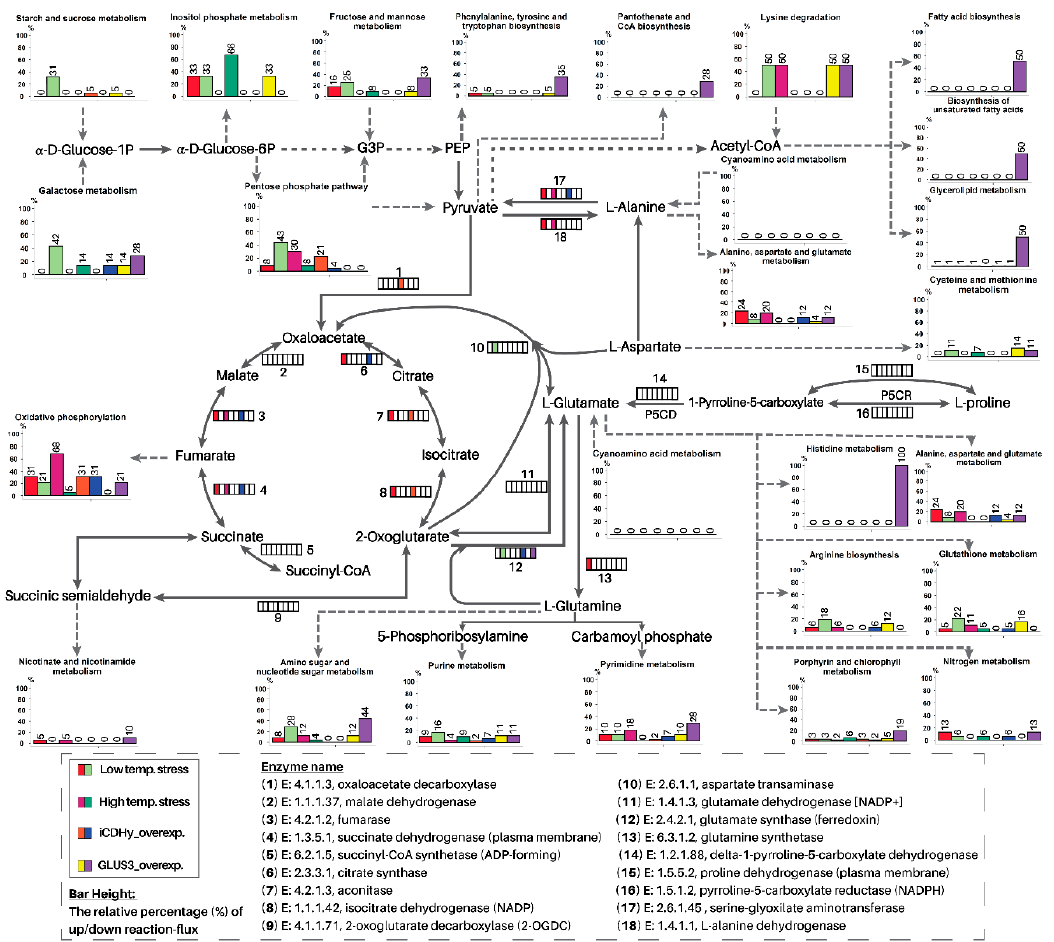
Figure 3. Schematic diagram representing the analysis of simulated metabolic flux of (i) the cells were grown at a low temperature (22 °C) and high temperature (40 °C), in comparison to that of the control, and (ii) the in silico overexpression of isocitrate dehydrogenase (iCDHy) and GlsF, in comparison to that of the control. The control is the simulated flux of the wild-type strain under optimal growth temperature at 35 °C. The central metabolic pathways, including those at the interconnection of carbon and nitrogen metabolism, were identified. The bar graphs illustrate the relative % of the affected reactions over the total reactions (100%) of each condition/mutant in the designated pathway. Note: Eight boxes in a row located over the reaction arrow represent the up and downregulated flux level compared between the treated and the control. The legends to up and downregulated flux (i) under the designated growth temperatures and (ii) of the in silico mutants are shown in the lower-left corner of the figure.